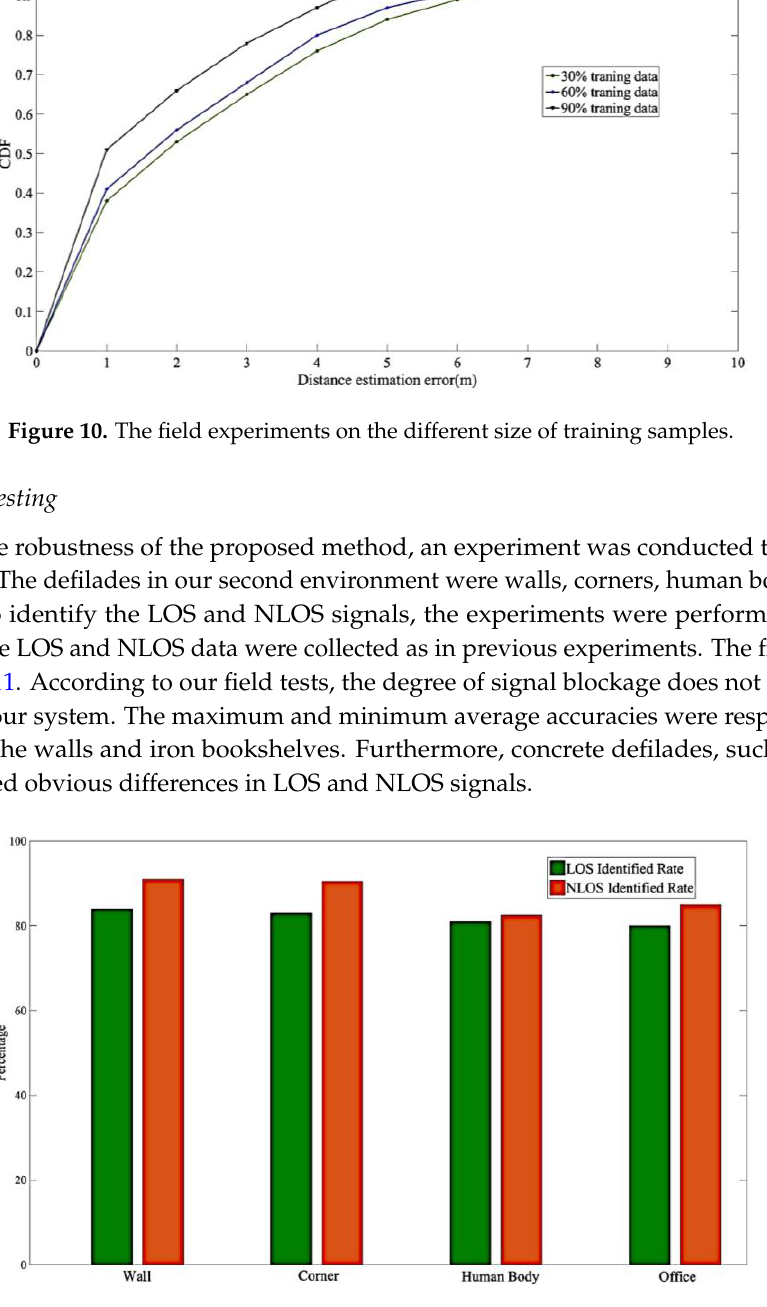
Figure 11. The robust testing on different defilades.